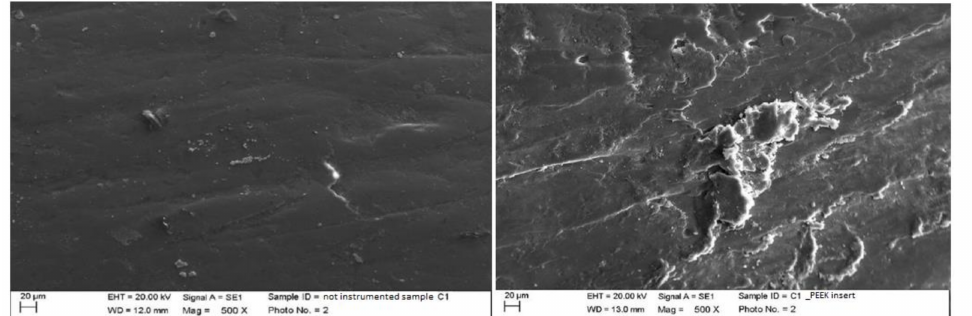
Figure 7. Instrumented composite sample C1 with peek insert (500 × ). Comparison before/after instrumentation.